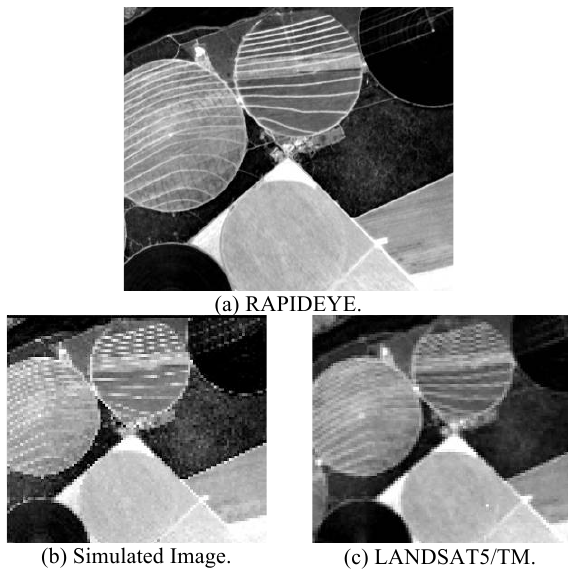
Figure 7. Green band radiometric profile for the methods studied. Figure 8. Red Band of (a) RAPIDEYE image, (b) simulated image and (c) real LANDSAT image.